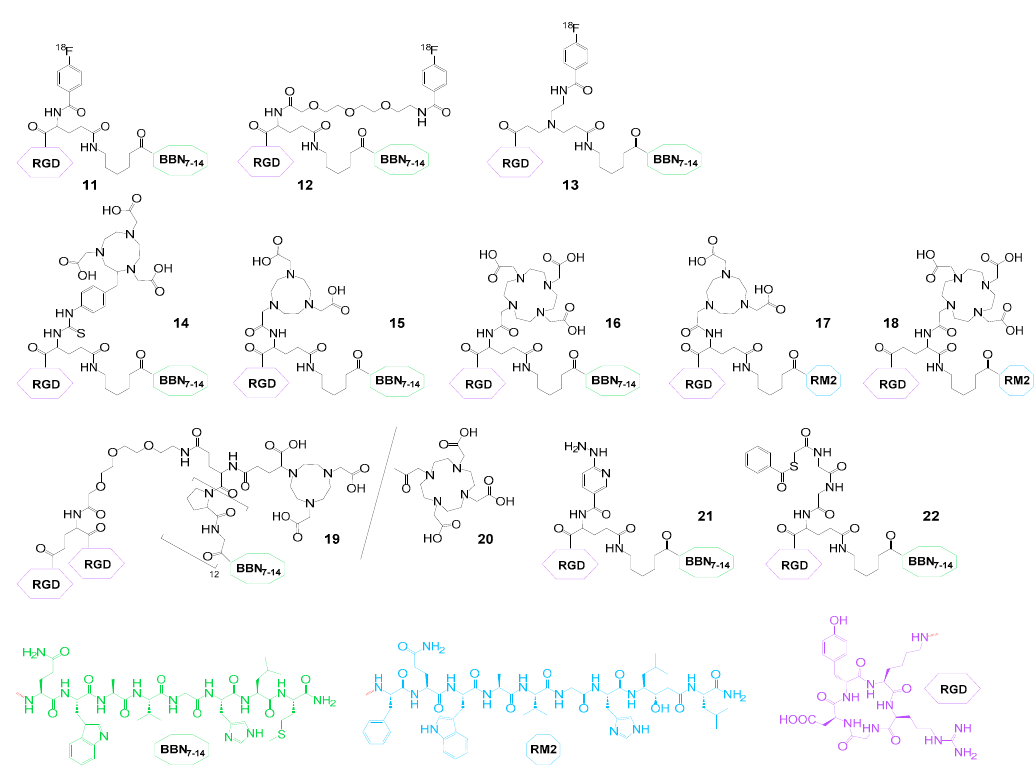
Figure 7. Structures of GRPR- and α v β 3 -bispecific agents developed thus far.